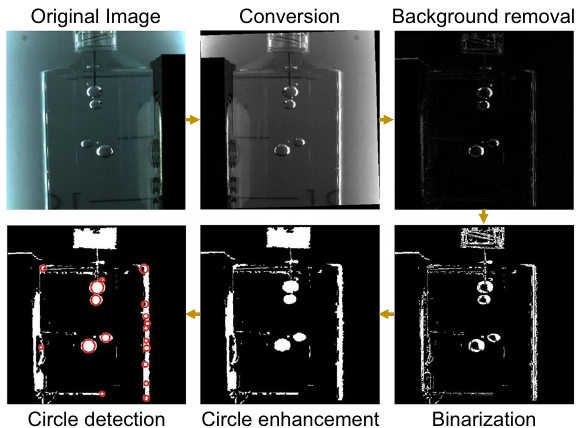
Fig. 9 Bubble detection algorithm applied to a representative video frame. The original frame is fi rst converted to gray-scale and fl ipped if the magnet is located on the right. After background removal, image binarization, and contour closing, bubbles are detected using the Circular Hough Transform. Detected bubbles are shown as red circles in the fi gure.